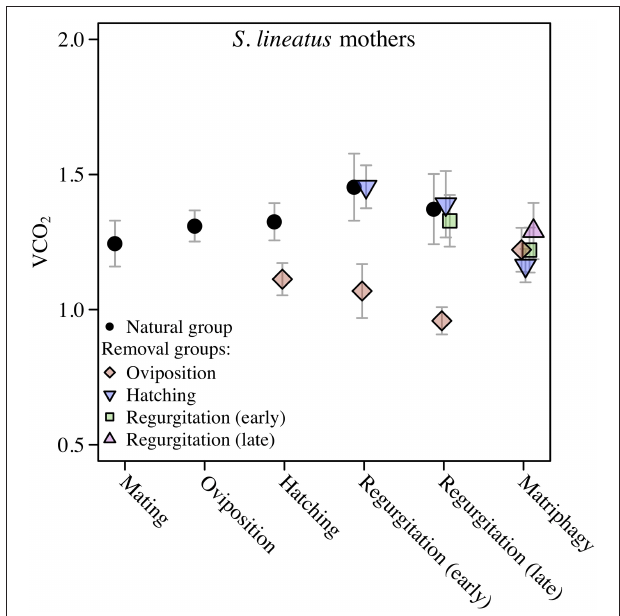
FIGURE 3 | Data on Standard Metabolic Rate (SMR) measured as VCO 2 ( µ L CO 2 /minute/gram) during the maternal care period in mothers of the solitary spider S. lineatus . SMR of natural mothers (reproducing females that followed a natural brood care cycle) was measured at mating, oviposition, hatching of offspring, early regurgitation and late regurgitation. Natural mothers succumbed to matriphagy and were thus not measured at this stage. In the removal groups, mothers were measured after removal of the egg sac or offspring at the same stages as well as at expected time of matriphagy. The VCO 2 measure provided is the average of the 3 lowest measurements out of 40. Error bars show the standard error of the mean. The natural group data presented here is the same data as presented in Figure 2A